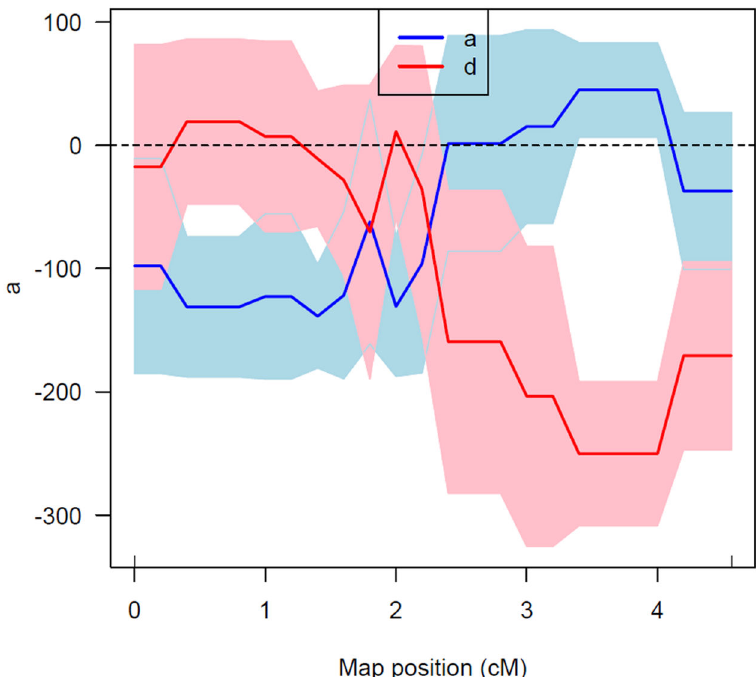
Figure 3. Effect scan at 0.2cM interval between the markers D5Rat256 and D5Wox37 explains the additive effect of the putative